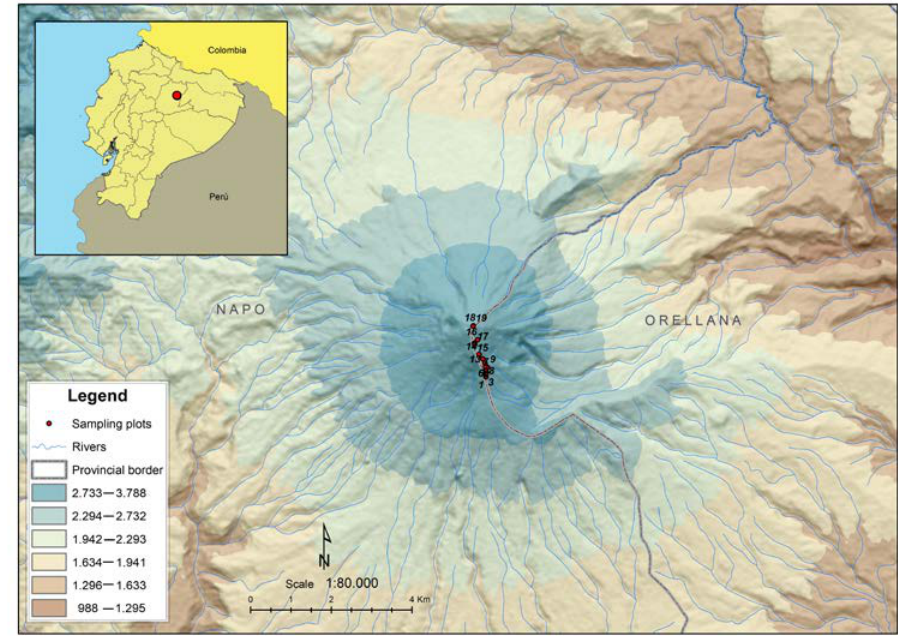
Figure 1. Location of the study area and distribution of the sampling plots along the cone of the Sumaco Volcano. Colors identify the various altitudinal classes.